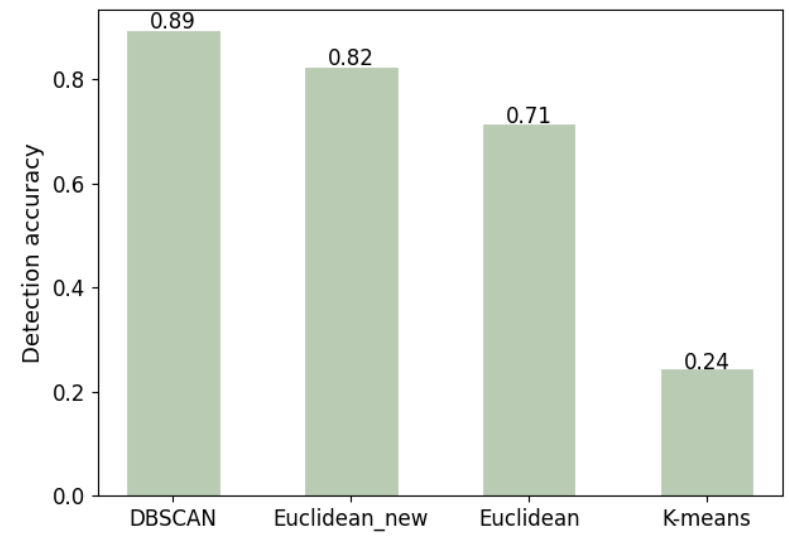
Figure 11. The accuracy of the four segmentation algorithms.